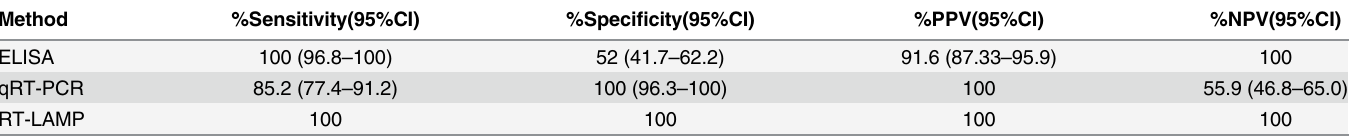
Table 3. Percentage of Sensitivity, specificity, PPV and NPV of ELISA, qRT-PCR and RT-LAMP for detection of dengue virus infection in human samples.